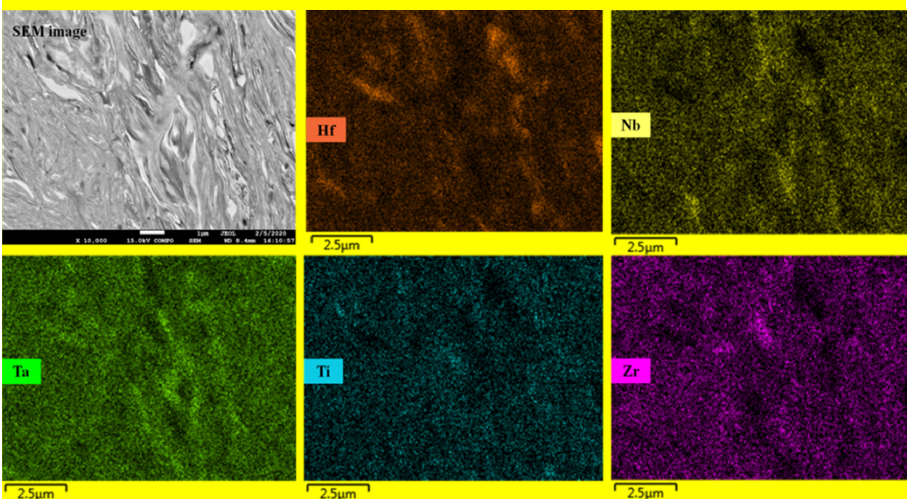
Figure 7. Representative compositional EDS mapping results for the HfTaTiNbZr sample ball milled for 10 h.